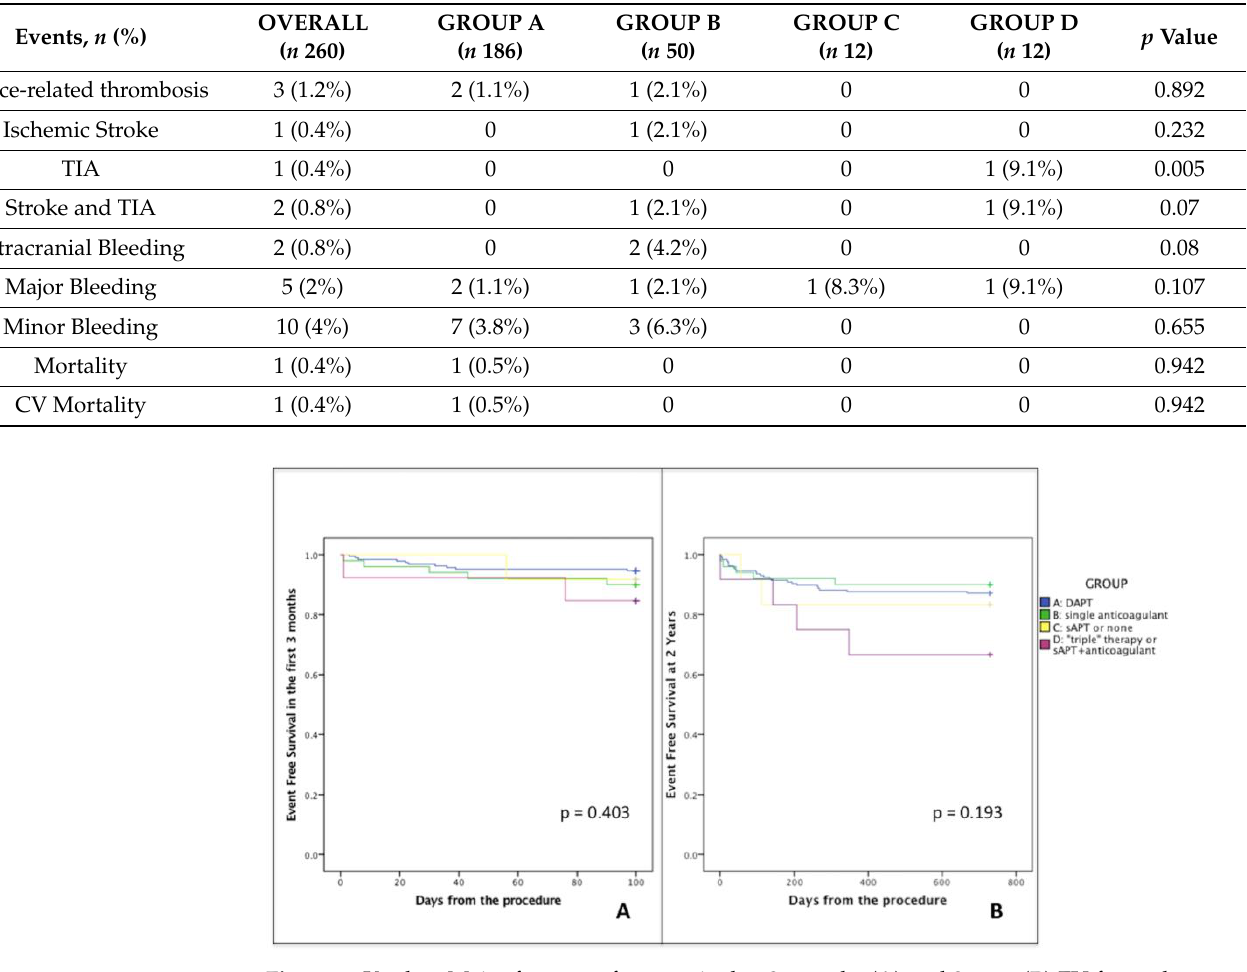
Figure 2. Kaplan–Meier for event free survival at 3-months ( A ) and 2-year ( B ) FU for each group: composite endpoint of left atrial thrombus on transesophageal echocardiography, ischemic stroke, transient ischemic attack, intracranial bleeding, major and minor bleeding, and all-cause mortality. GROUP A dual antiplatelet therapy; GROUP B anticoagulant therapy; GROUP C single antiplatelet therapy or no therapy; GROUP D combination of antiplatelet and anticoagulant therapy. Table 4. Long term clinical follow-up. FU: follow-up; TEE: transesophageal echocardiography; TIA: transient ischemic attack. GROUP A dual antiplatelet therapy; GROUP B anticoagulant therapy; GROUP C single antiplatelet therapy or no therapy; GROUP D combination of antiplatelet and anticoagulant